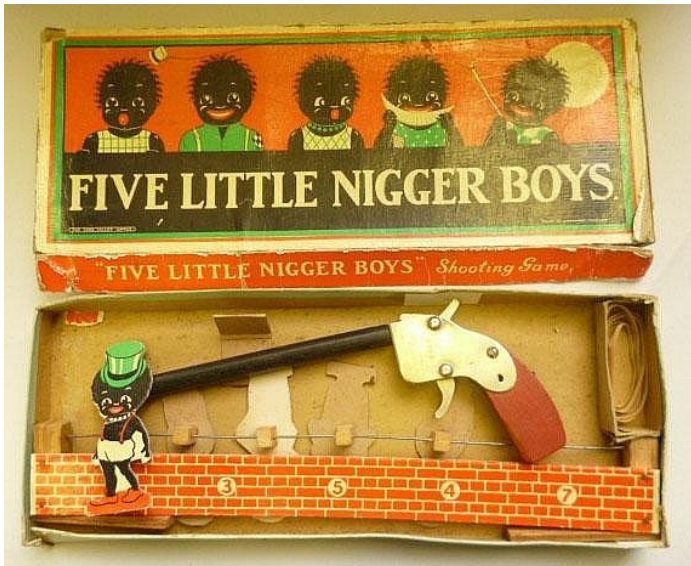
Figure 4. Chad Valley Company Ltd. (1950a) shooting game with Black children as targets.